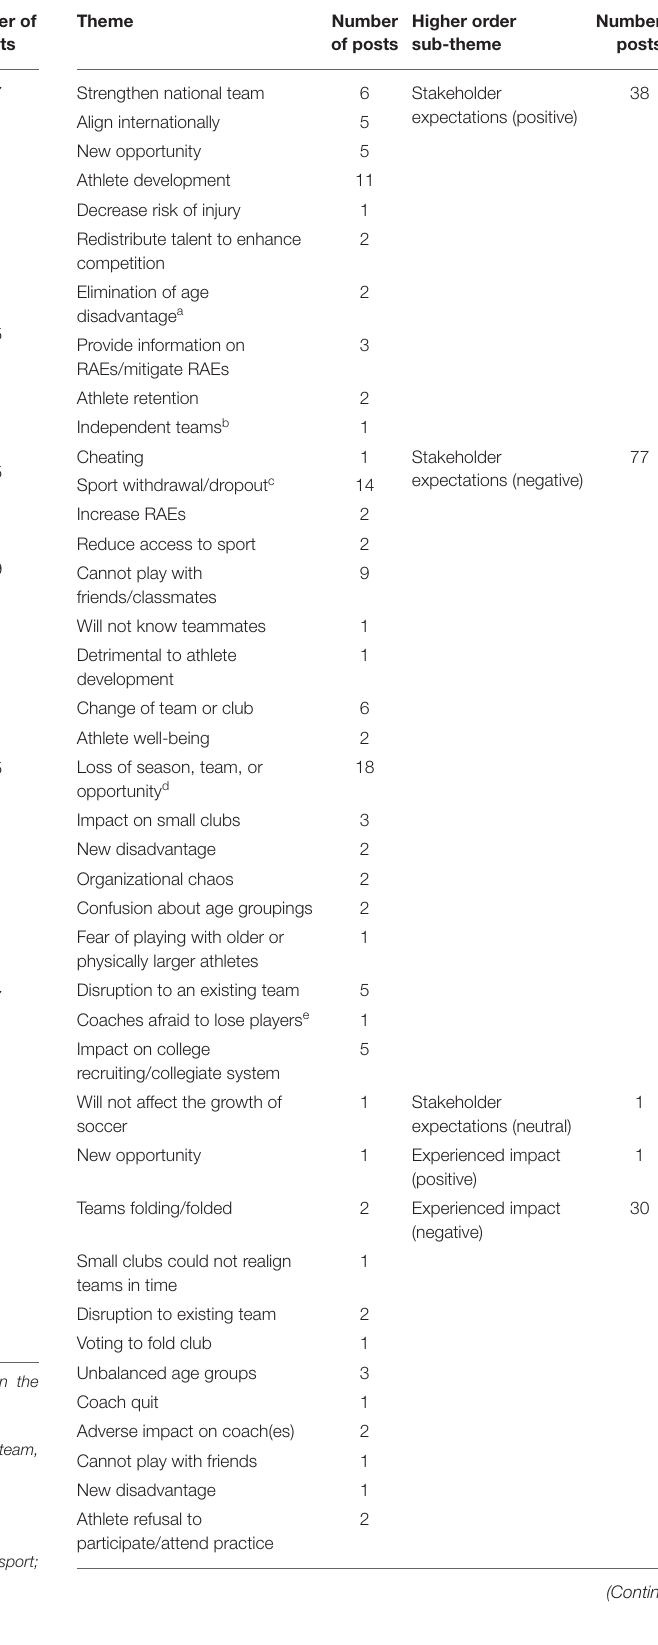
TABLE 2 | Category: stakeholder discussion. TABLE 3 | Category: outcomes identified by